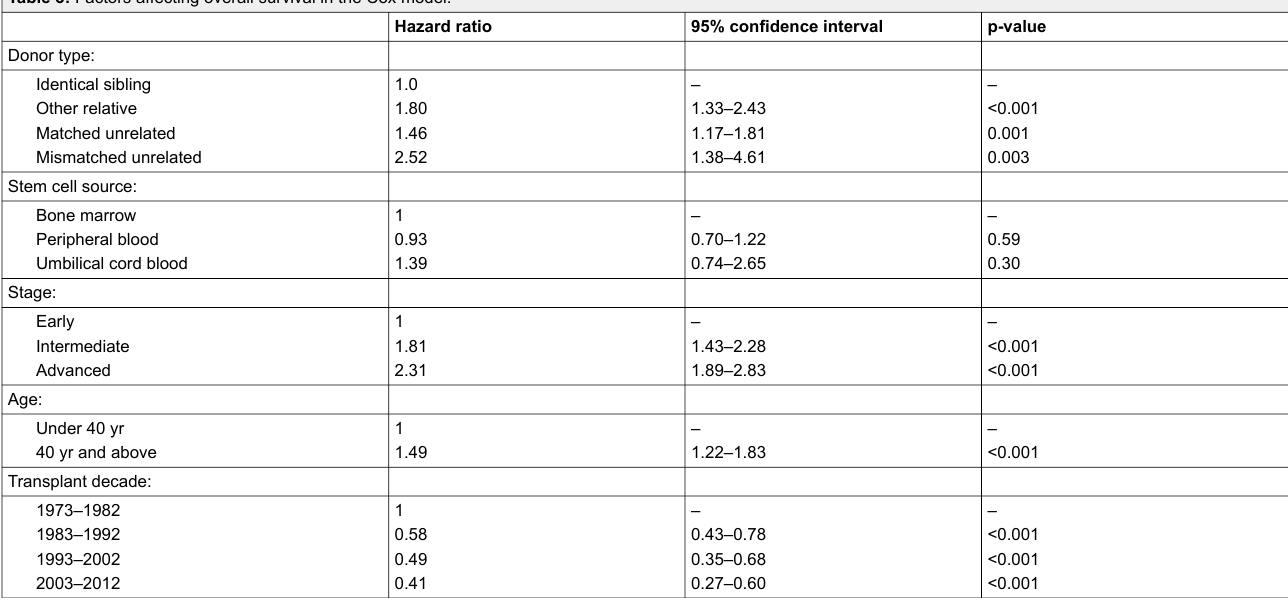
Table 3: Factors affecting overall survival in the Cox model.